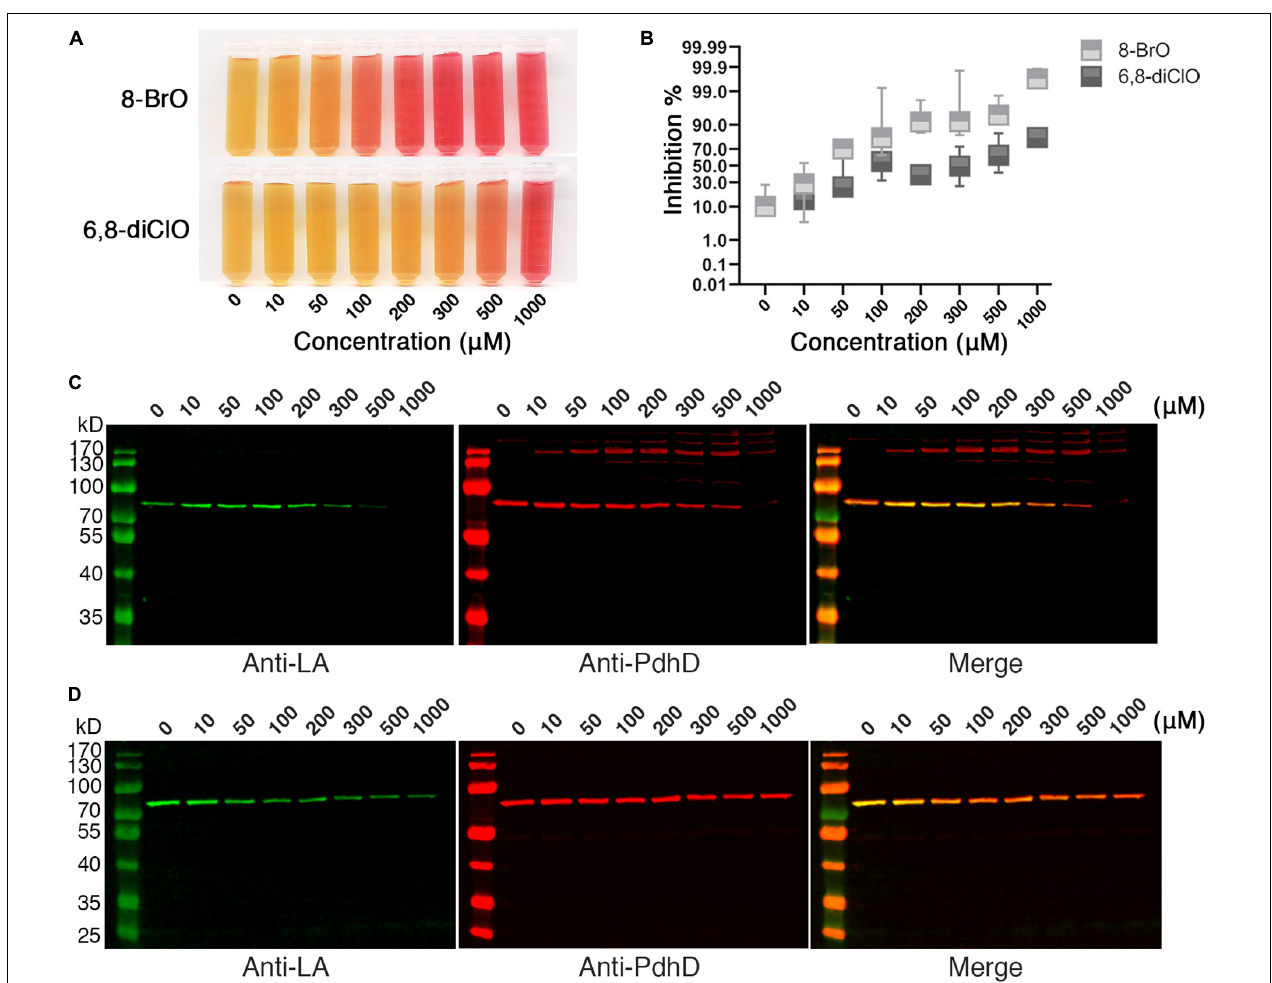
FIGURE 8 | Effects of lipoic acid analogs on M. hyopneumoniae cultures. (A) Effects of lipoic acid analogs on M. hyopneumoniae in vitro growth. M. hyopneumoniae were cultured for 10 days in the presence of indicated concentrations of 8-BrO or 6,8-diClO. The color change of the medium (containing phenol red indicator) roughly reflects the bacterial concentration. (B) The inhibition rate of 8-BrO and 6,8-diClO at different concentrations. The number of viable M. hyopneumoniae was estimated by CCU assay. (C) Effect of 8-BrO at different concentrations on PdhD lipoylation. To collect enough cells for western blot assays, the samples with different concentrations of 8-BrO were cultured for another 10 days. Not enough M. hyopneumoniae were collected under a concentration of 1000 µ M. (D) Effect of 6,8-diClO at different concentrations on PdhD